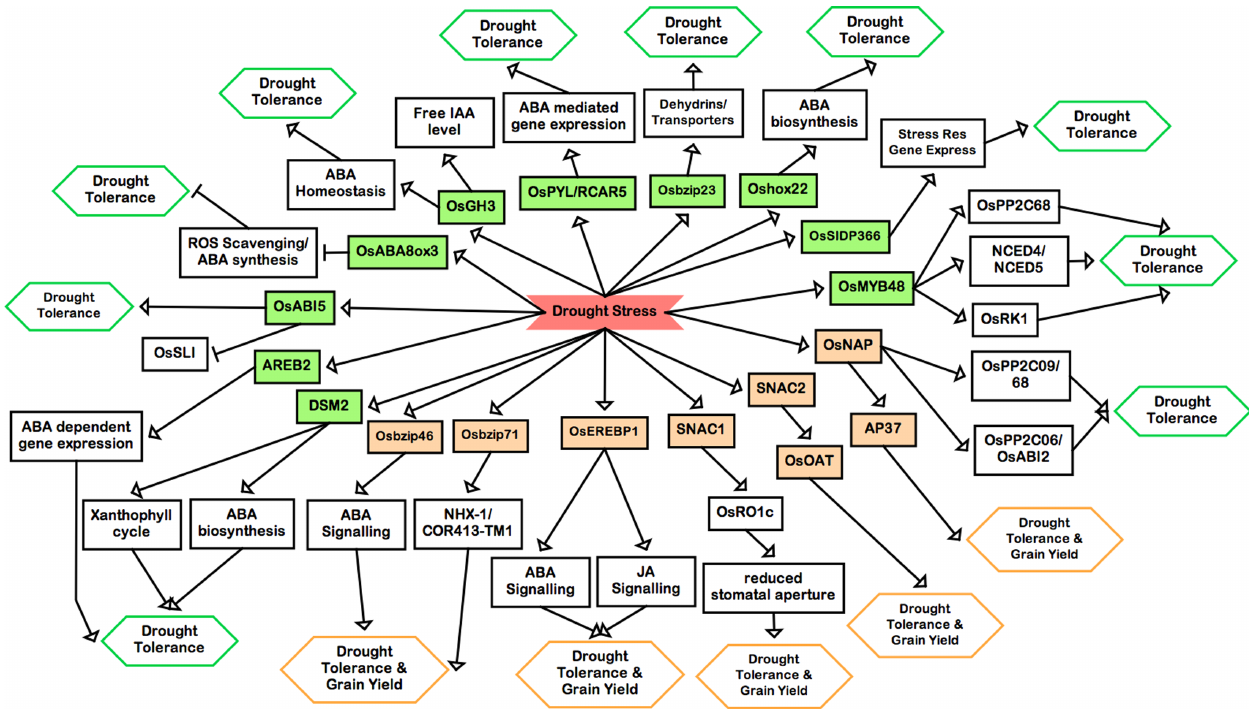
Figure 1. The abscisic acid (ABA)-dependent gene regulatory pathway in rice. This pathway is required for drought stress tolerance and grain yield under drought. The drought stress ABA-dependent signal is shown perceived directly by the regulatory genes described in the text, followed by transcriptional regulation of downstream genes and underlying stress response mechanisms. Genes regulating drought tolerance (DT) at the vegetative stage are shaded green, and genes regulating DT and grain yield under drought are shaded orange. The resulting phenotypes are represented for DT at the vegetative level only (green diamonds), or DT and grain yield (orange diamonds). The genes described here are OsGH3 92 , OsNAP , OsABI2 39 , AP37 93 , OsPP2C09 , OsPP2C06 94 , OsPYL/RCAR5 , OsSIDP366 95 , OsMYB48 96 , OsRK1 97 , Oshox22 98 , SNAC2 99,100 , OsOAT 101 , OsbZIP23 102 , SNAC1 99 , OsEREBP1 103 , OsbZIP71 104 , OsbZIP46 105 , OsABI5 106 , DSM2 40 , AREB2 107 , OsSRO1c 108 , and OsABA8OX3 109